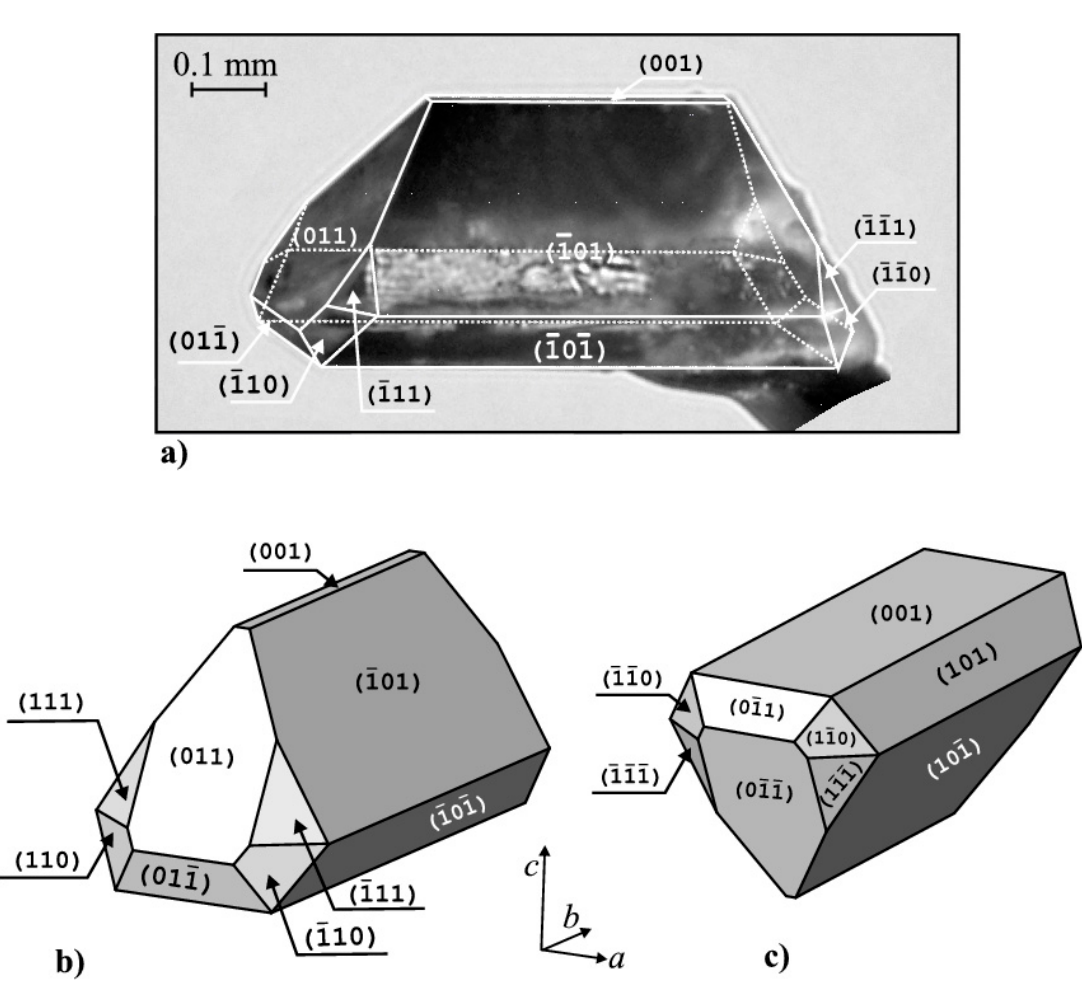
Figure 2. A view of struvite habit and morphology; ( a ) struvite grown in gel medium and ( b ) its schematic representation with faces indexed in accordance with the coordinate system assumed